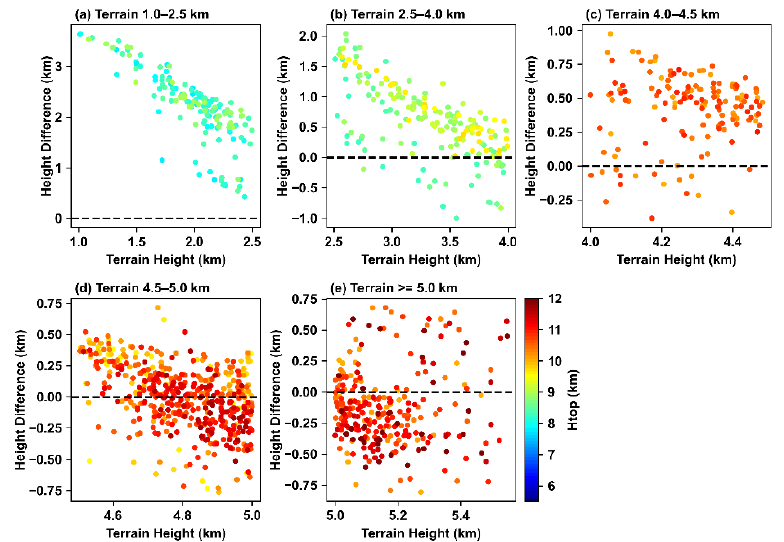
Figure 10. The difference between the mean height of the minimum value of environmental moist static energy (the turning point) and cloud base height (units: km) in different terrain height ranges above 1 km terrain height; the black horizontal line denotes 0 km; the color bar denotes the cloud top height in each grid.